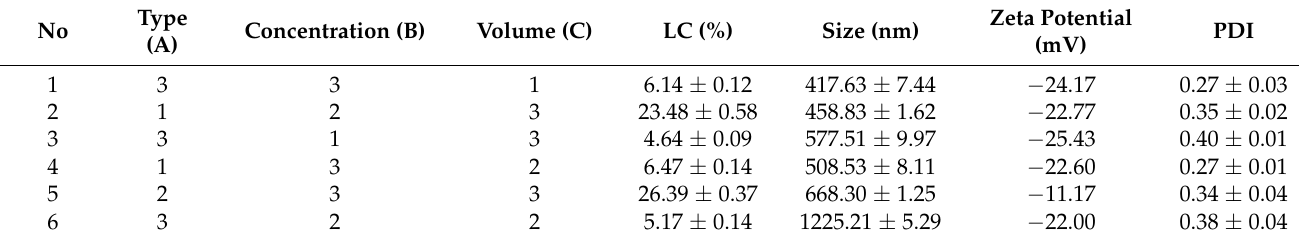
Table 2. The design and results of the orthogonal